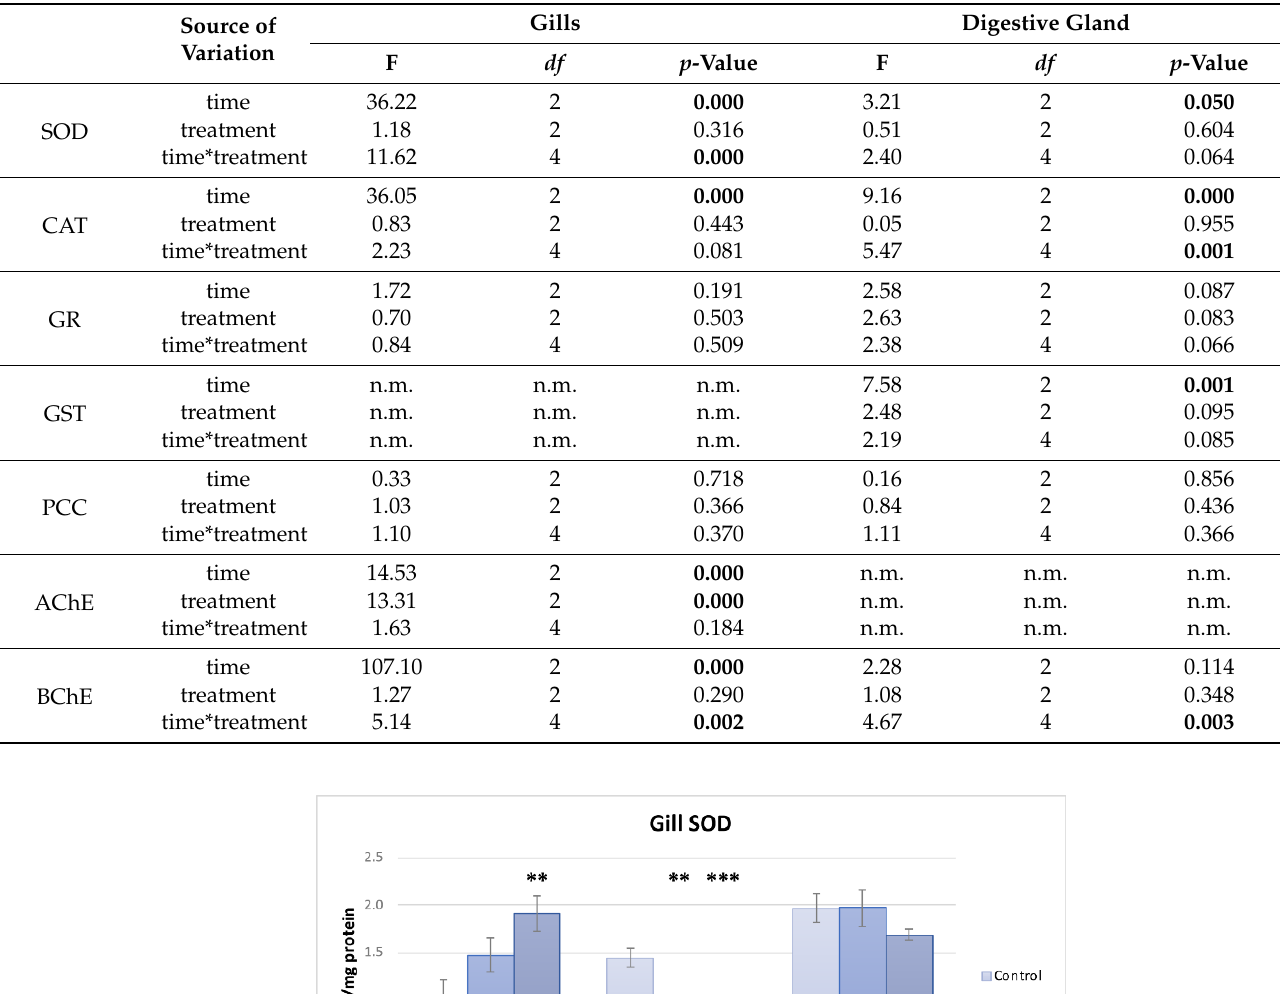
Table 3. Results of two-way ANOVA analysis for the biomarkers measured in gills and digestive gland of Ruditapes philippinarum after exposure to HHCB. Statistically significant influences of the variables “time”, “treatment” and “time*treatment” interaction are indicated in bold ; n.m.: not measured. Gills Digestive Gland Source of Variation F df p -Value F df p -Value